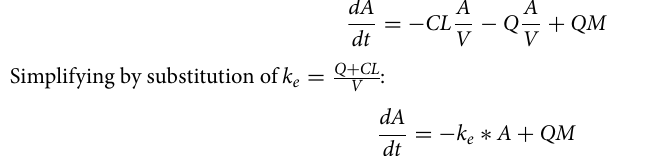
To describe the disposition kinetics of each compound in the zebrafish, exploratory analysis of the fluo- rescence time profiles showed a fast distribution from the injection site for IP and PC injections, supporting a 1-compartment model as the most parsimonious description of the data. Exchange with the environment (at compound concentration M, in mg/L) was described as a superposition of one-way active clearance CL (L/h) and passive exchange Q (L/h) (Eqs. 2, 3 and 4, Fig. 8).